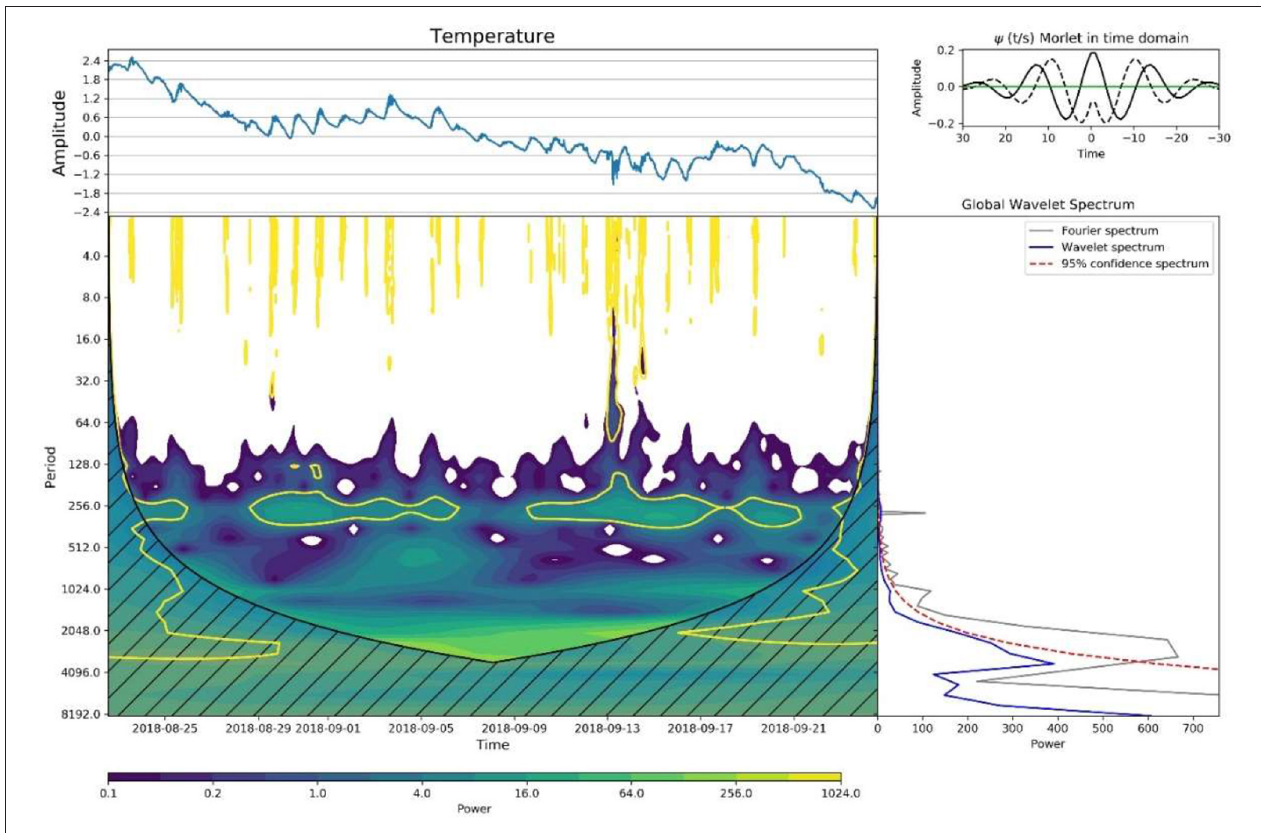
FIGURE 6 | Wavelet analysis –